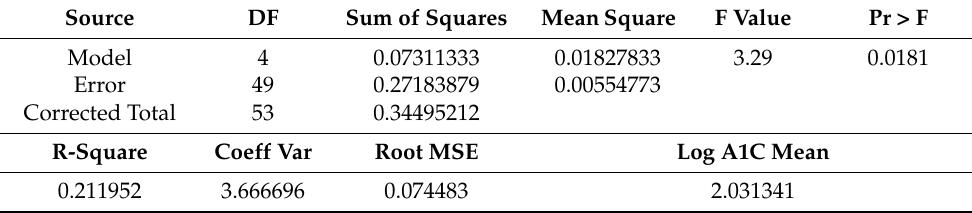
Table A10. GLM with log A1C ≥ 1.95% (log ≥ 7% equivalent) as dependent